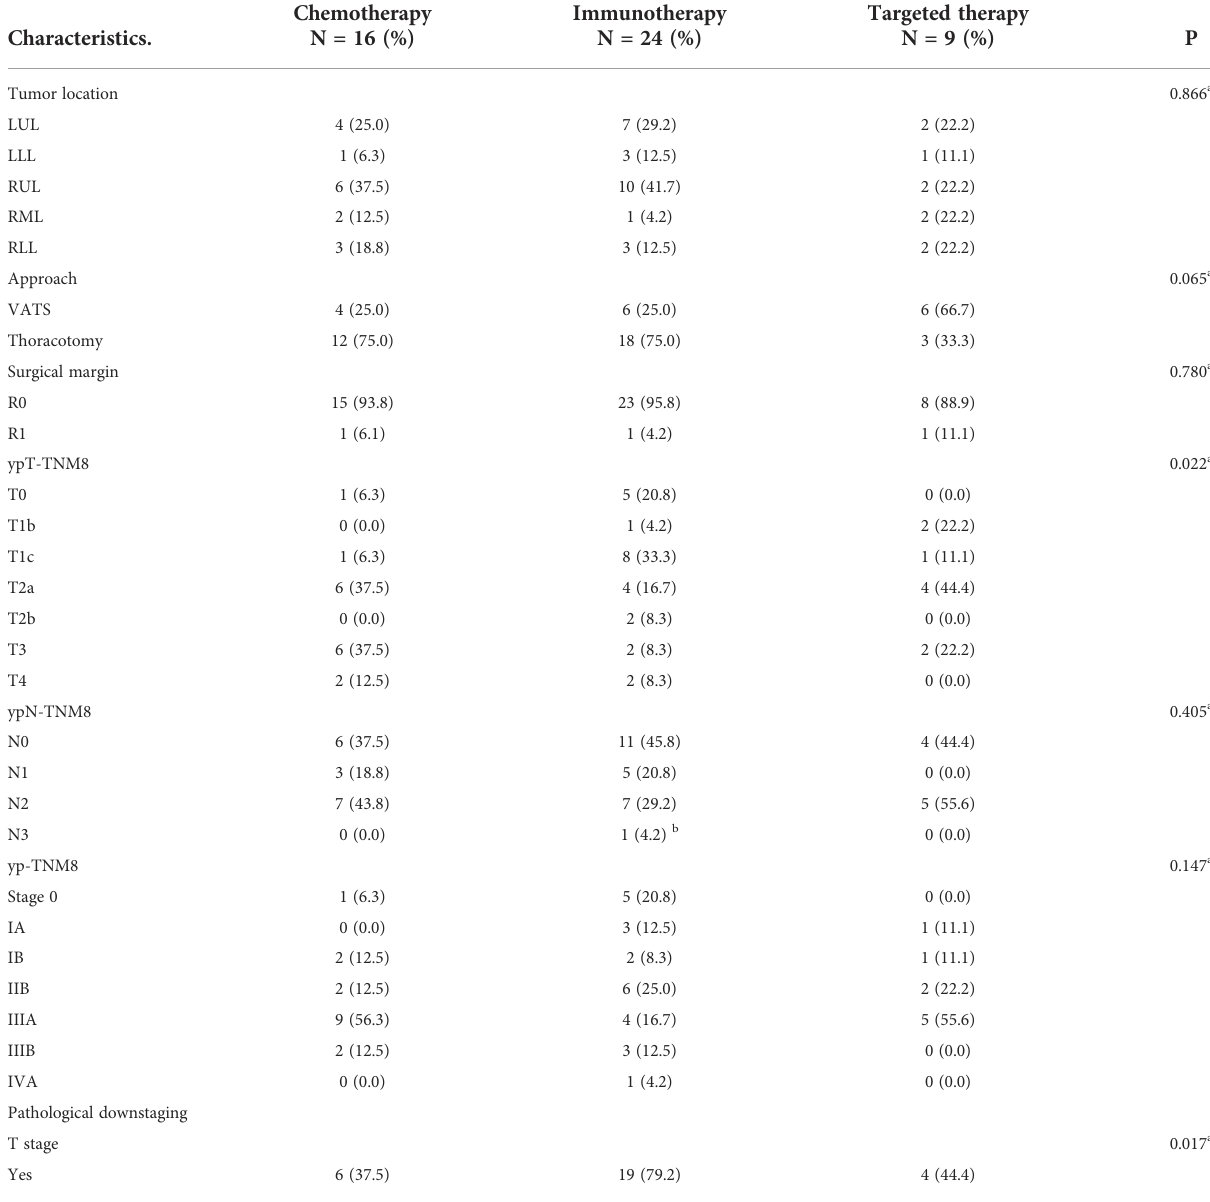
TABLE 3 Tumor location, surgical approach, and surgical outcomes of operable locally advanced NSCLC patients in different neoadjuvant therapy groups. Chemotherapy Immunotherapy Targeted therapy